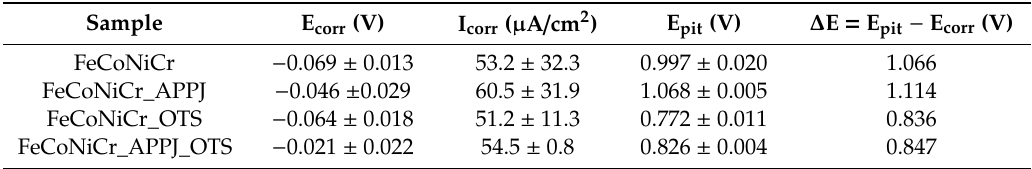
Figure 4. Potentiodynamic polarization test curves of bare, OTS-coated, APPJ-treated, and OTS-coated APPJ-treated FeCoNiCr MEAs. Table 1. E corr and I corr for bare, OTS-coated, APPJ-treated, and OTS-coated APPJ-treated FeCoNiCr MEAs. Three measurements were